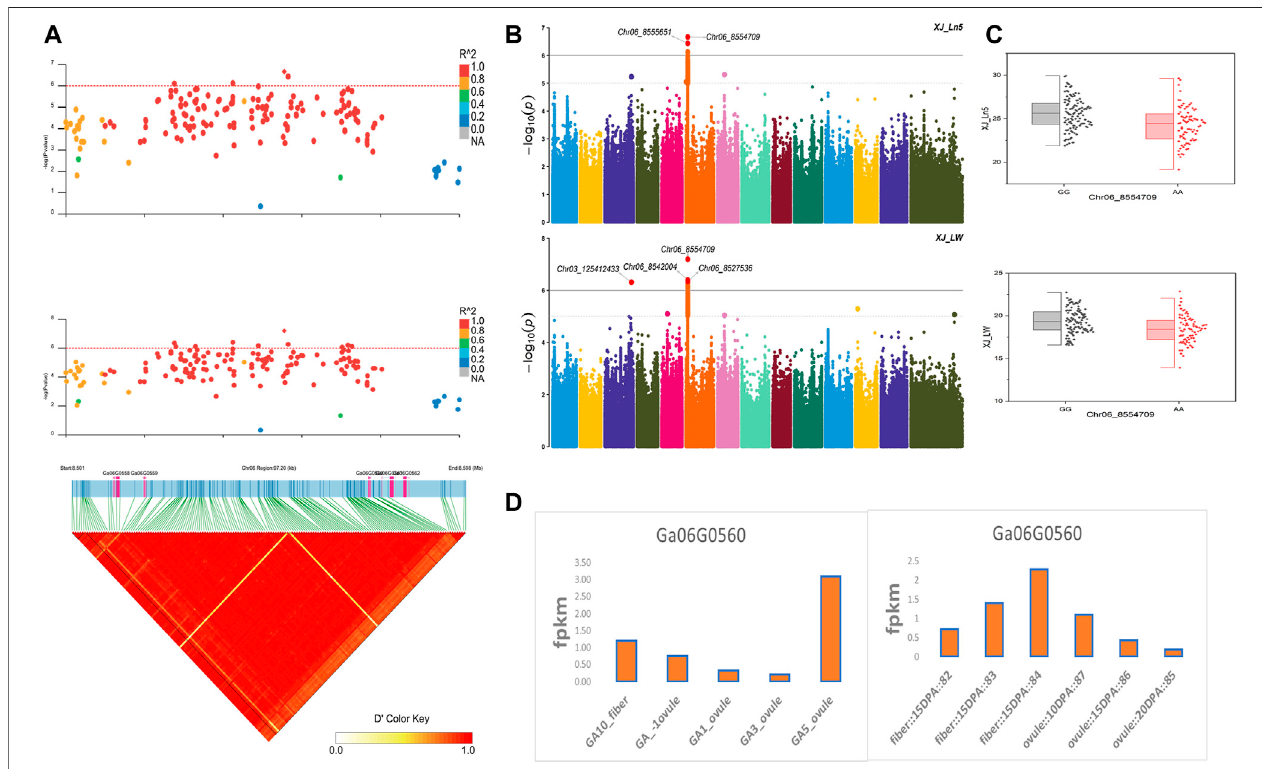
FIGURE8| Genome-wideassociationstudiesforLengthin G.arboreum (A) GWAS-LDblockdemonstratinghaplotyperegion(97.20 kb)surroundingtheexposed peak on chromosome Chr06 associated with Length related traits along with GWAS regional plot revealing key SNPs and nearby gene(s) in the region (B) Manhattan plots for Length related traits: XJ_Ln5 and XJ_LW dotted-horizontal line in each plot describes signi fi cance threshold value kept at [ − log ( p ) > 6] (C) Box plots exhibiting differences for Length related traits among two favorable haplotypes of SNP Chr06_8554709: XJ_Ln5 and Chr06_8554709: XJ_LW (D) Expression levels of representative annotated gene Ga06G0559 at different developmental stages of G . arboreum from two different sources.